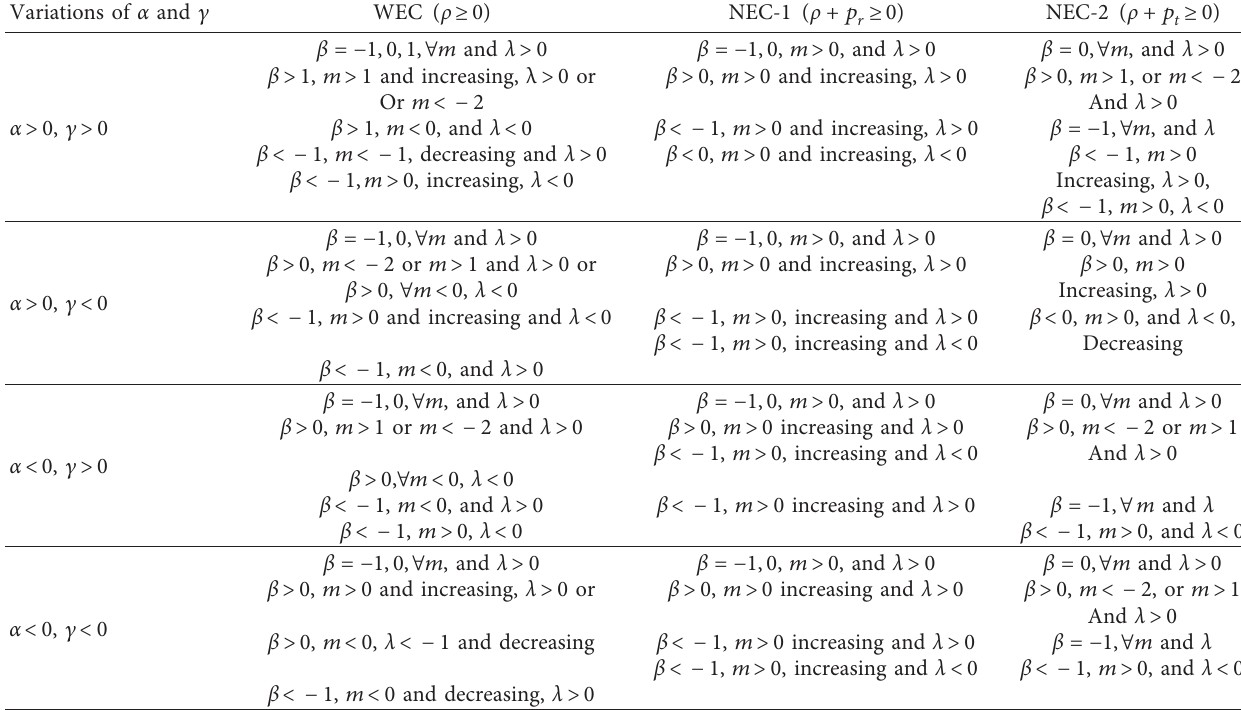
Table 2: Validity regions of WEC and NEC in f ( R , T ) gravity with the quadratic term in trace T . Variations of α and